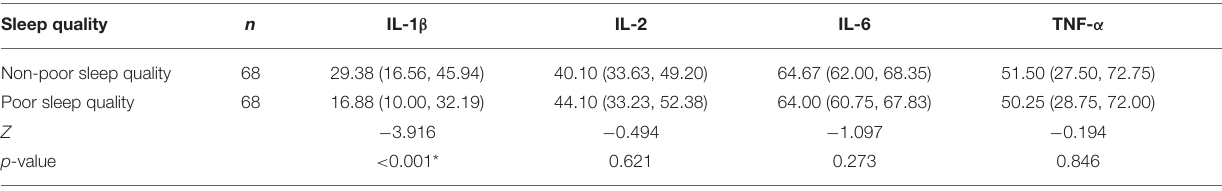
TABLE 4 | Cytokine comparison between different sleep quality groups.